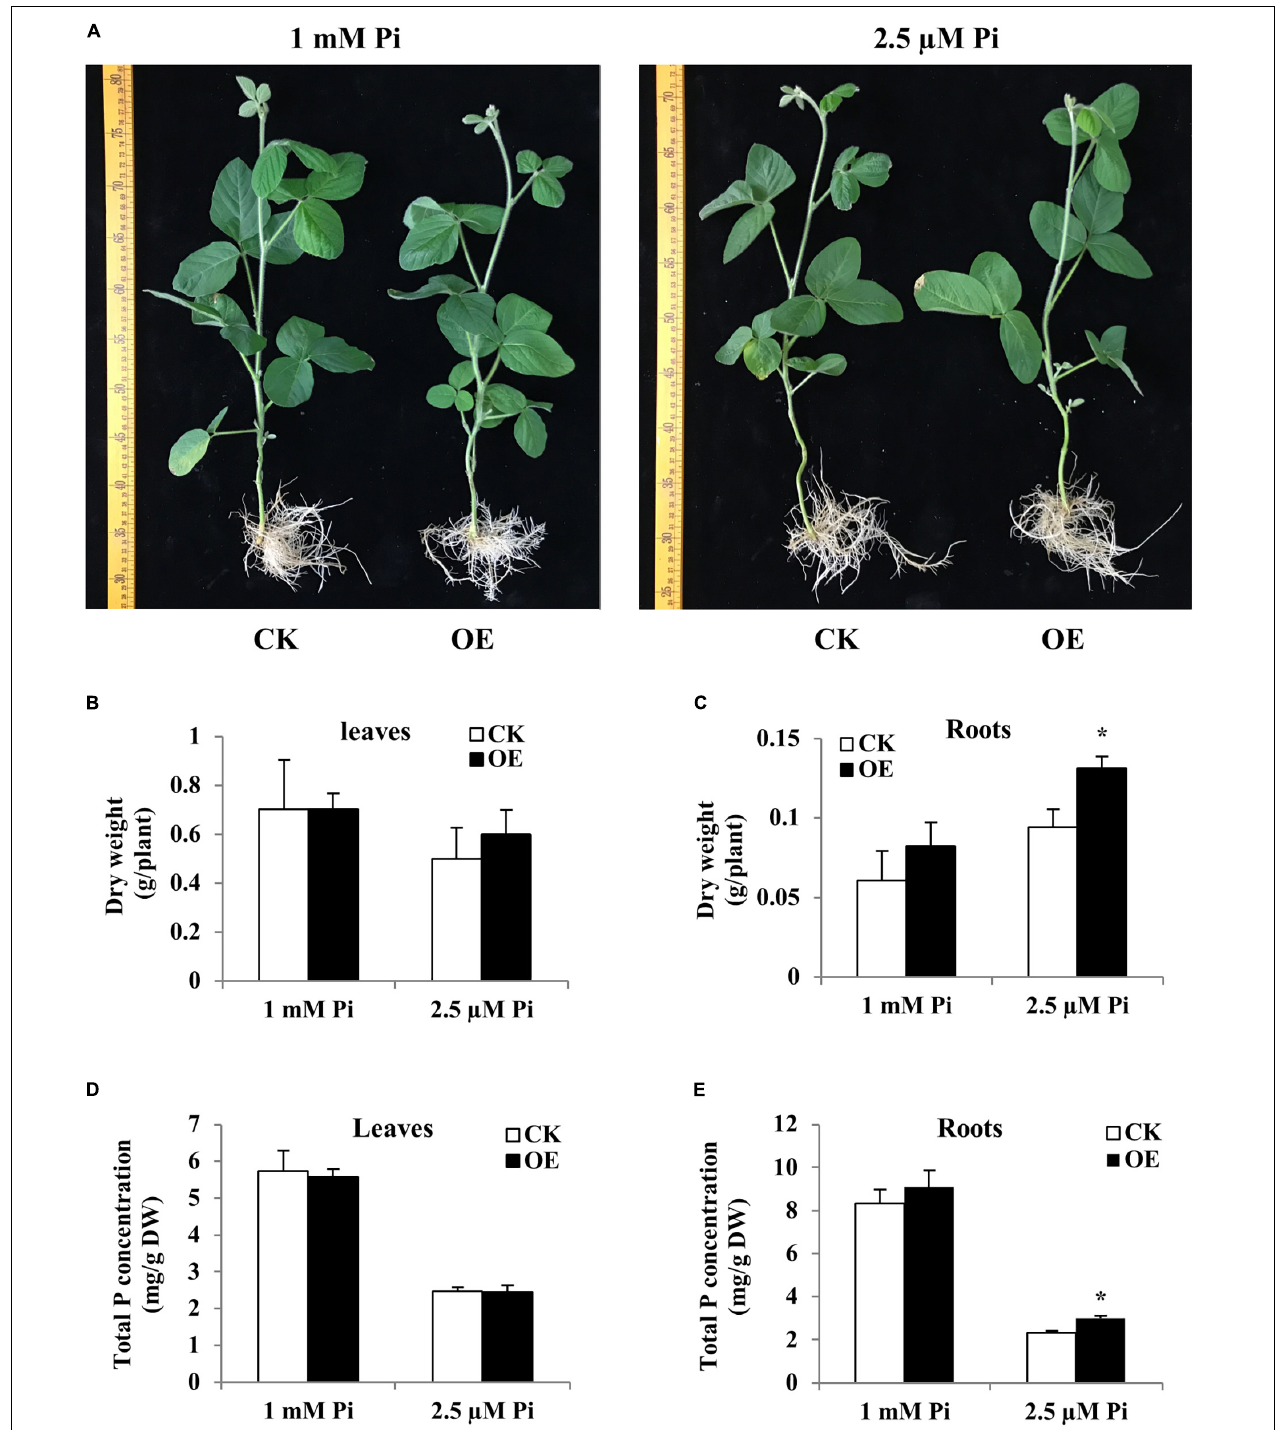
FIGURE 3 | Comparison of control (CK) and Gm6PGDH1 -overexpressing composite soybean plants under two Pi level conditions. Composite soybean plants with transgenic hairy roots were grown with a normal nutrient solution for 2 days, and then the plants were switched to a nutrient solution containing 1 mM or 2.5 µ M KH 2 PO 4 . After 14 more days, the leaves and roots were separately harvested for analysis. (A) Phenotype of composite soybean plants. Scale unit: cm. (B) Dry weight of leaves. (C) Dry weight of roots. (D) Total P concentration of the leaves. (E) Total P concentration of the roots. CK represents the composite plants transformed with the empty vector; OE indicates Gm6PGDH1 -overexpressing composite plants. DW means dry weight. Data are means ± SD of three biological replicates. Asterisks indicate significant differences between OE and CK (Student’s t -test, * P < 0.05).